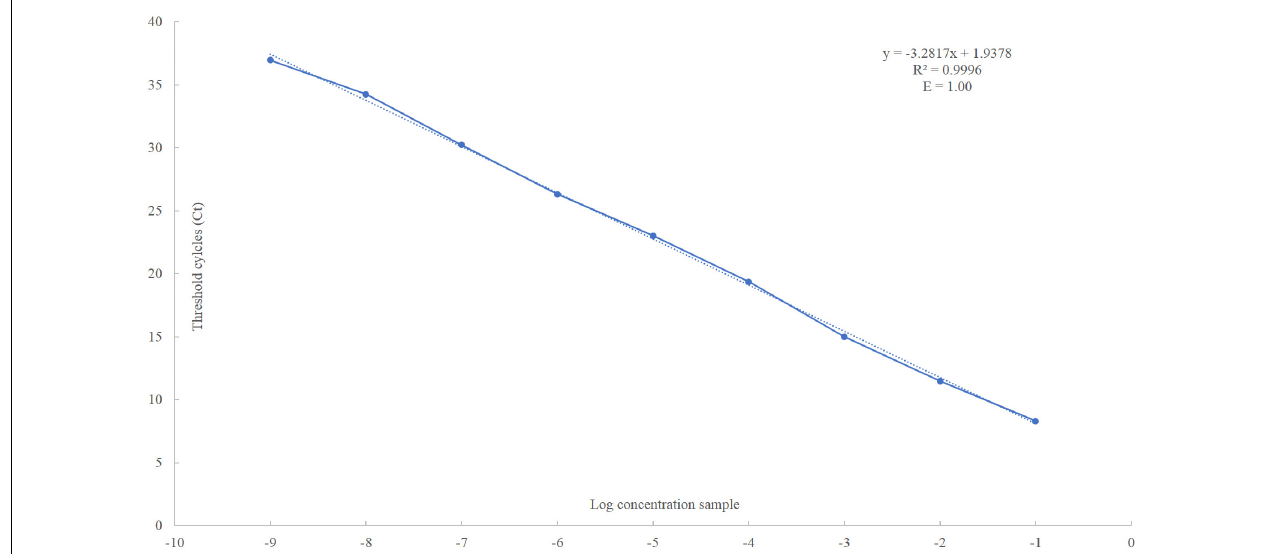
FIGURE 2 | Linear regression analysis, plotting the Ct value in the Y-axis vs. the logarithm of the starting RNA dilutions in the X-axis. Each plotted point represents the mean Ct value that was calculated from the four different experiments with two replicates. The calculated correlation coefficient ( R 2 ) and amplification efficiency ( E ) values are indicated in each curve. TABLE 4 | Number of samples and percentage of positive samples analyzed by end point RT-PCR and RT-qPCR during the years 2018–2020. Sampling year End point RT-PCR RT-qPCR Samples Positive % Positive Samples Positive % Positive analyzed samples sample analyzed samples